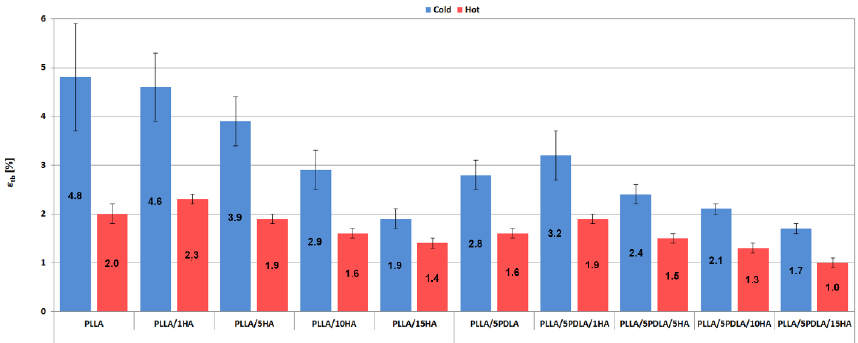
Figure 4. Tensile strength plots of samples from cold and hot molds.